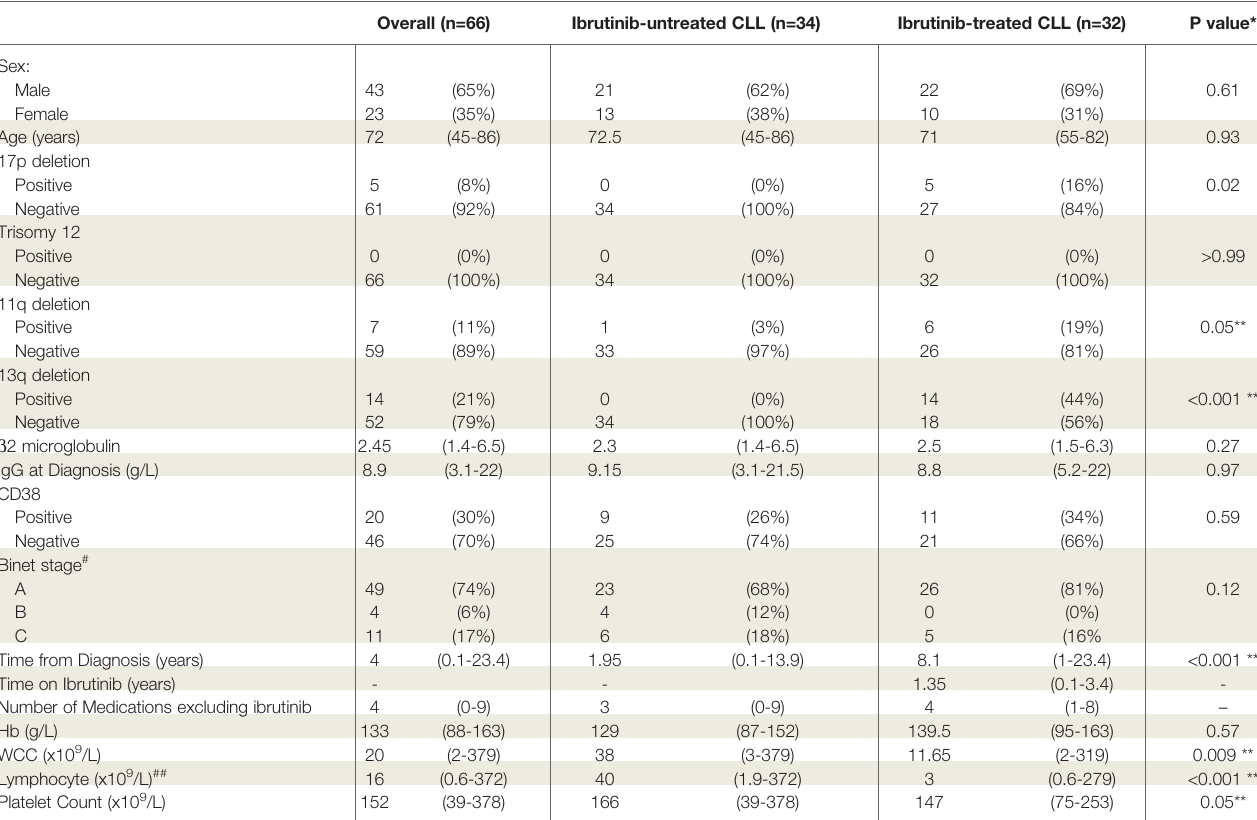
TABLE 1 | Characteristics of chronic lymphocytic leukemia patients enrolled in the study. Overall (n=66) Ibrutinib-untreated CLL (n=34)